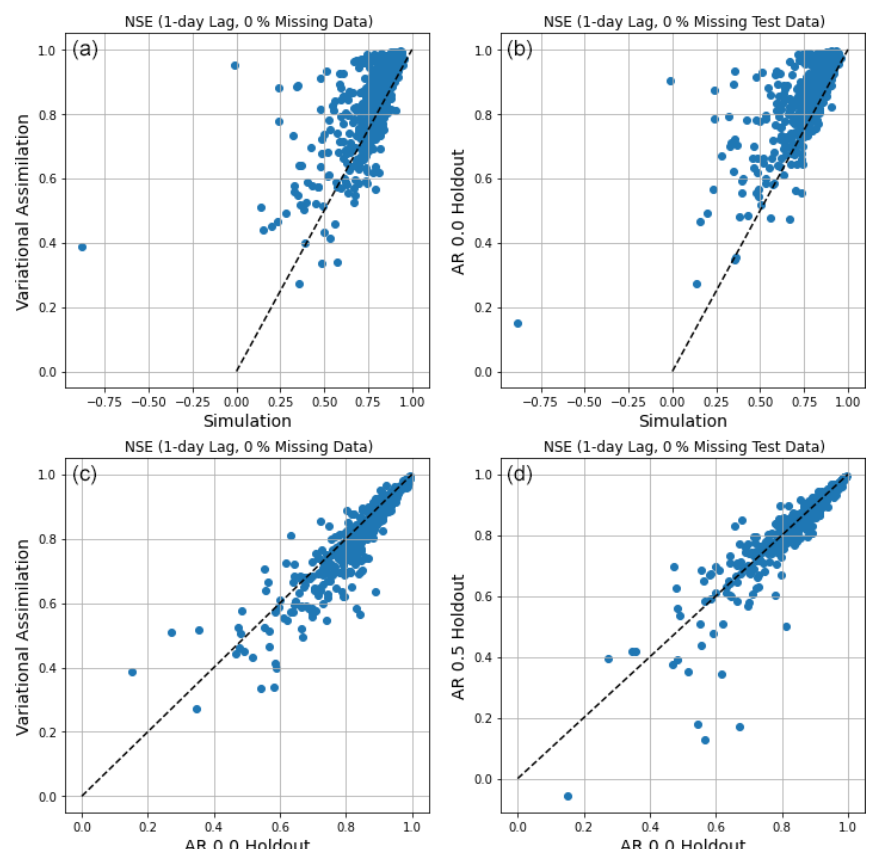
Figure 2. Comparison of per-basin NSEs with an observation lag of 1d: (a) simulation vs. DA with no missing data, (b) simulation vs. AR with no missing data, (c) AR vs. DA with no missing data, and (d) AR with no missing data vs. AR with 50% missing data during inference (no missing data during training to be comparable with other models shown in these plots). Table 2. Median performance metrics over 531 CAMELS